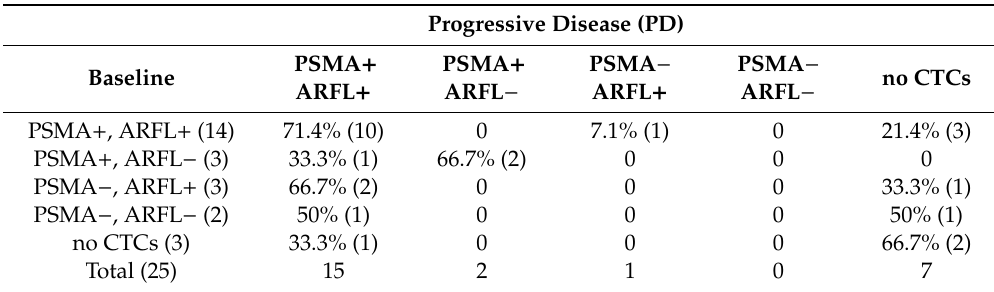
Table 6. ARFL and PSMA conversion at PD. Percentages refer to the fraction of patients within groups who at baseline shared biomarker constellation (first column). Numbers in brackets refer to the number of patients with specific PSMA / ARFL profile / total number of patients analyzed at